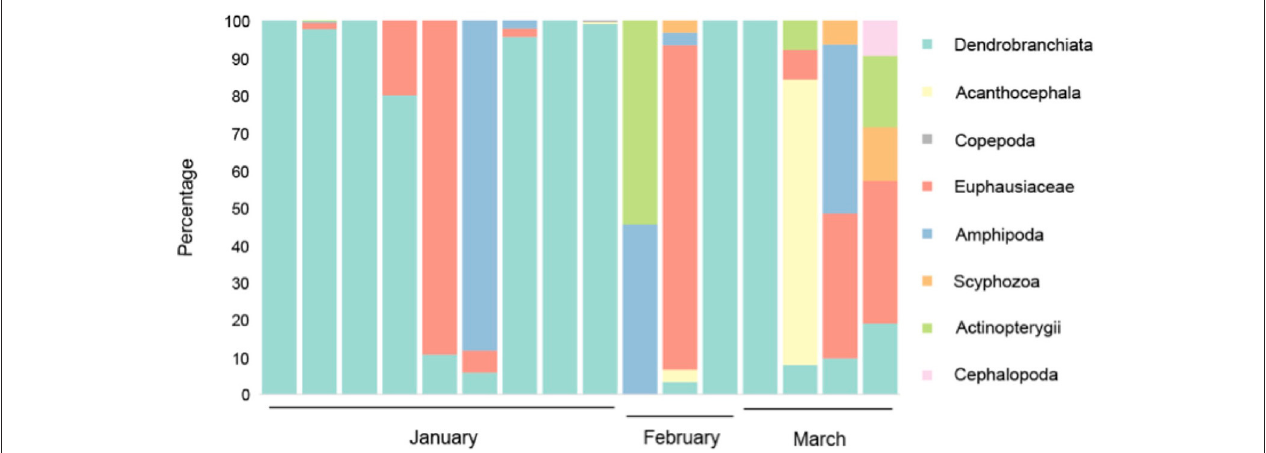
FIGURE 1 | Prey species detected in Northern Indian Ocean blue whale fecal samples. Each column represents a single sample. Percentage of amplicons belonging to each prey group extracted from samples is indicated. The lack of a consistent, diverse background of amplicons suggests that the primary source of the amplicons amplified from the fecal samples is dietary rather than derived from